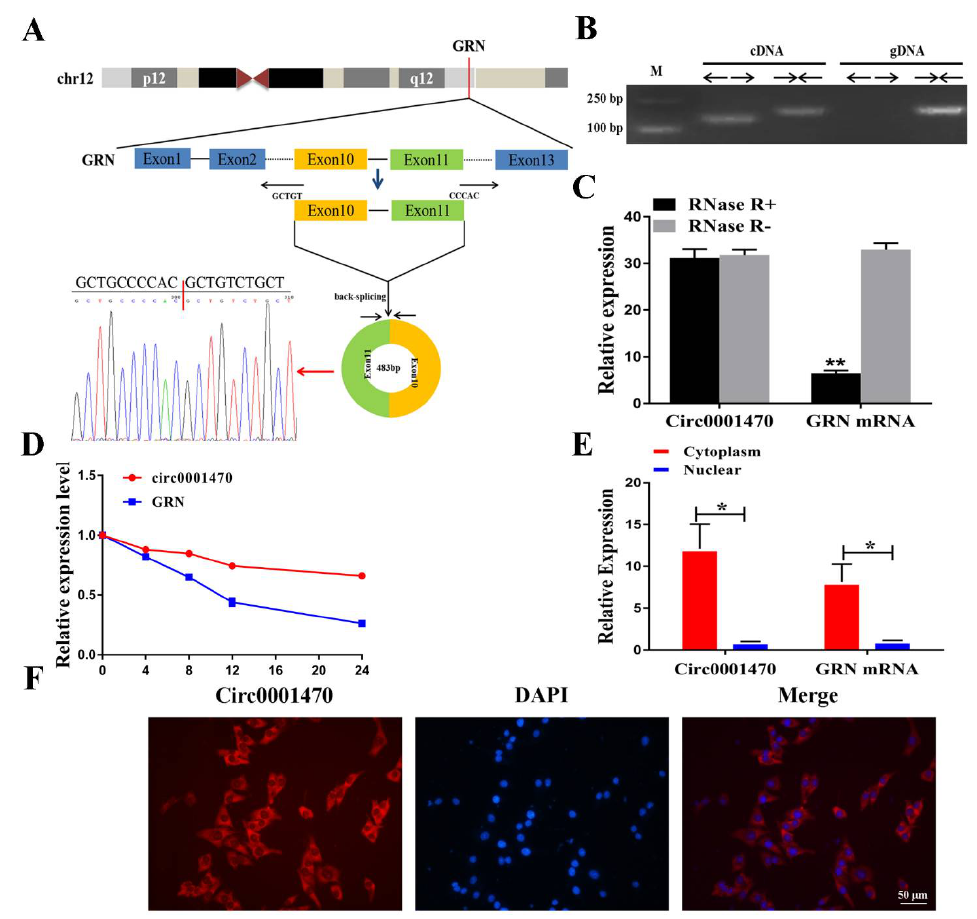
Figure 2. Characterization of circ0001470 RNA in EECs. ( A ) A sketch of the structure of circ0001470, which was generated from an exon10 and exon11 region of the GRN gene via back-splicing. ( B ) PCR analysis for circ0001470 and linear isoform GRN in cDNA and genomic DNA (gDNA). ( C ) Re- sistance of circ0001470 and linear transcript GRN by qRT-PCR after RNase enzyme treatment of EECs. ( D ) qRT-PCR for the abundance of circ0001470 and GRN in EECs treated with Actinomycin D at the indicated time points. ( E ) qRT–PCR data indicated the abundance of circ0001470 and GRN mRNA in the cytoplasm and nucleus of EECs. The circ0001470 and GRN mRNA levels were nor- malized to the value measured in the cytoplasm. ( F ) The localization of circ0001470 was detected by FISH. Circ0001470 was labeled by red fluorescence. Nuclei were stained with 4,6-diamidino-2-phe- nylindole (DAPI). Scale bar, 50 μm. Data are presented as mean ± standard deviation. All data are representatives of three independent experiments. * p < 0.05, ** p < 0.01. 3.3. Circ0001470 Promotes EECs Proliferation, Cycle Transition, and Suppresses Apoptosis To explore the biological function of circ0001470 in EECs, EECs were purified by col- lagenase I digestion of endometrial tissue, followed by differential centrifugation (Sup- plementary Figure S2A). The overexpression vector of circ0001470 was successfully con- structed (Figure 3A), as it increased circ0001470 expression level without influencing GRN mRNA level (Figure 3B). Two siRNAs were designed to silence circ0001470 without